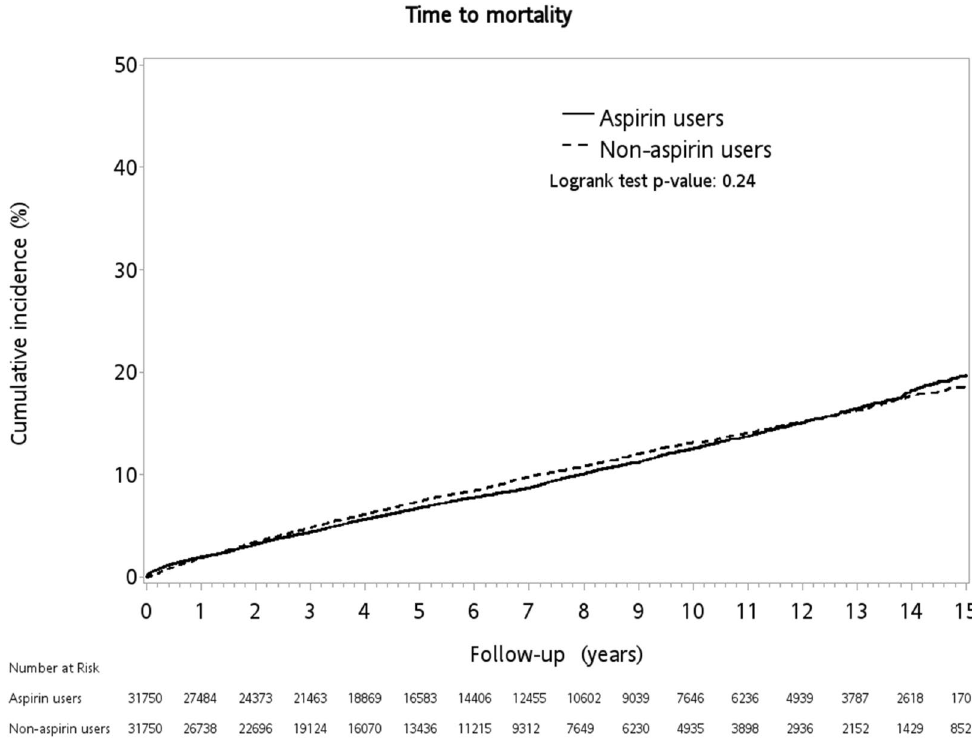
Figure 3. Kaplan–Meier curve of in-hospital mortality in diabetic patients with or without aspirin